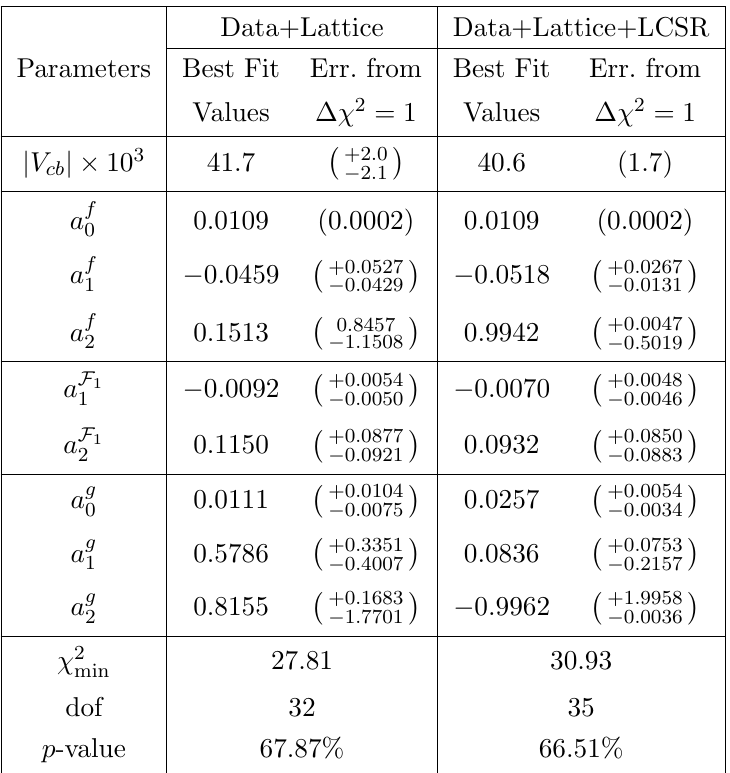
Table 10 . Fit results with BGL parameterization of the form factors ( N = 2) in B ! D (cid:3) ‘(cid:23) ‘